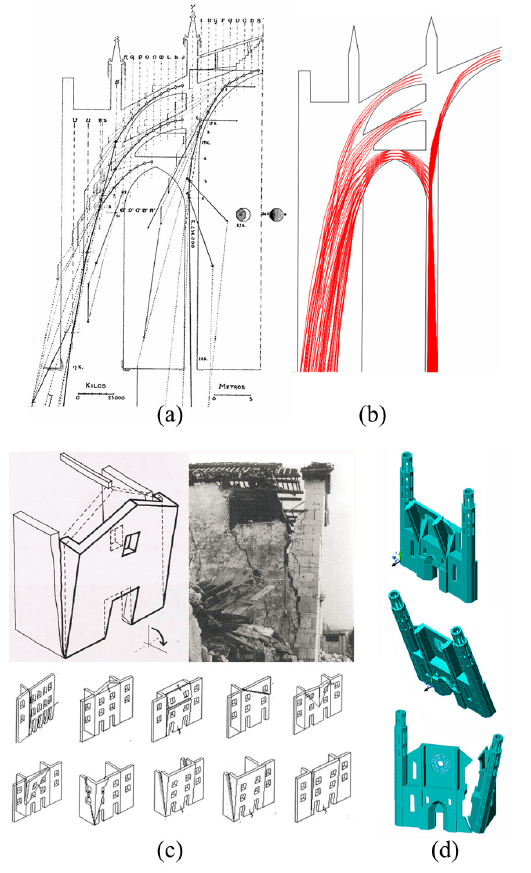
Figure 10. Mallorca cathedral: (a) Thrust line application from Rubió, 1912; (b) numerous alternative thrust lines, from analytical calculations [24]. Kinematic analyses: (c) an abacus of out‐of‐plane overturning modes [25]; (d) definition of collapse mechanisms for the façade of Santa Maria del Mar church in Barcelona